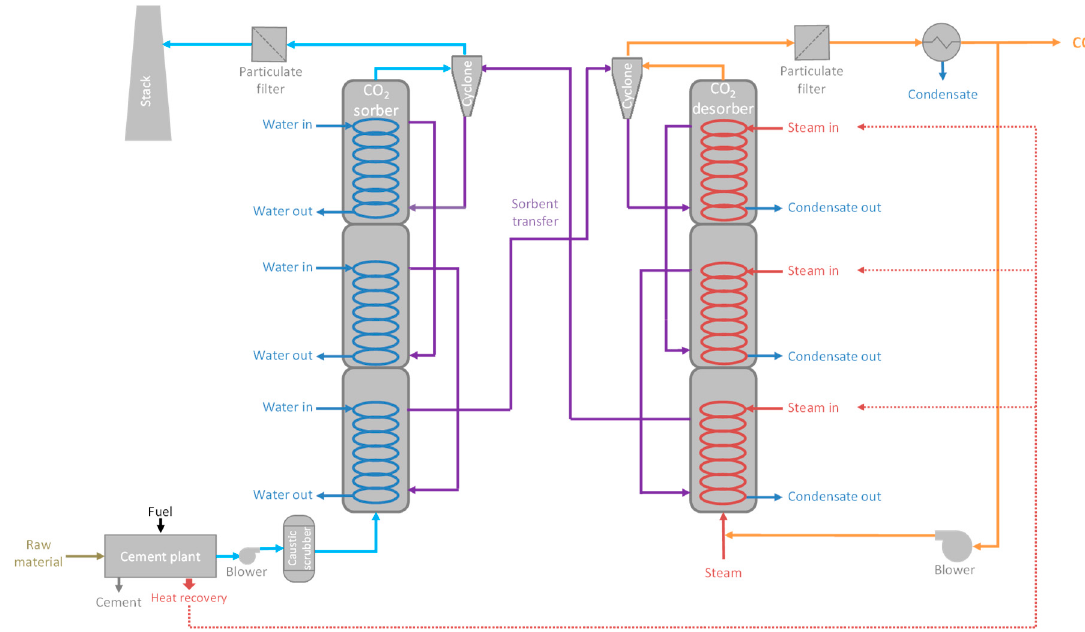
Figure 9. RTI’s solid sorbent technology (adapted from [56]).